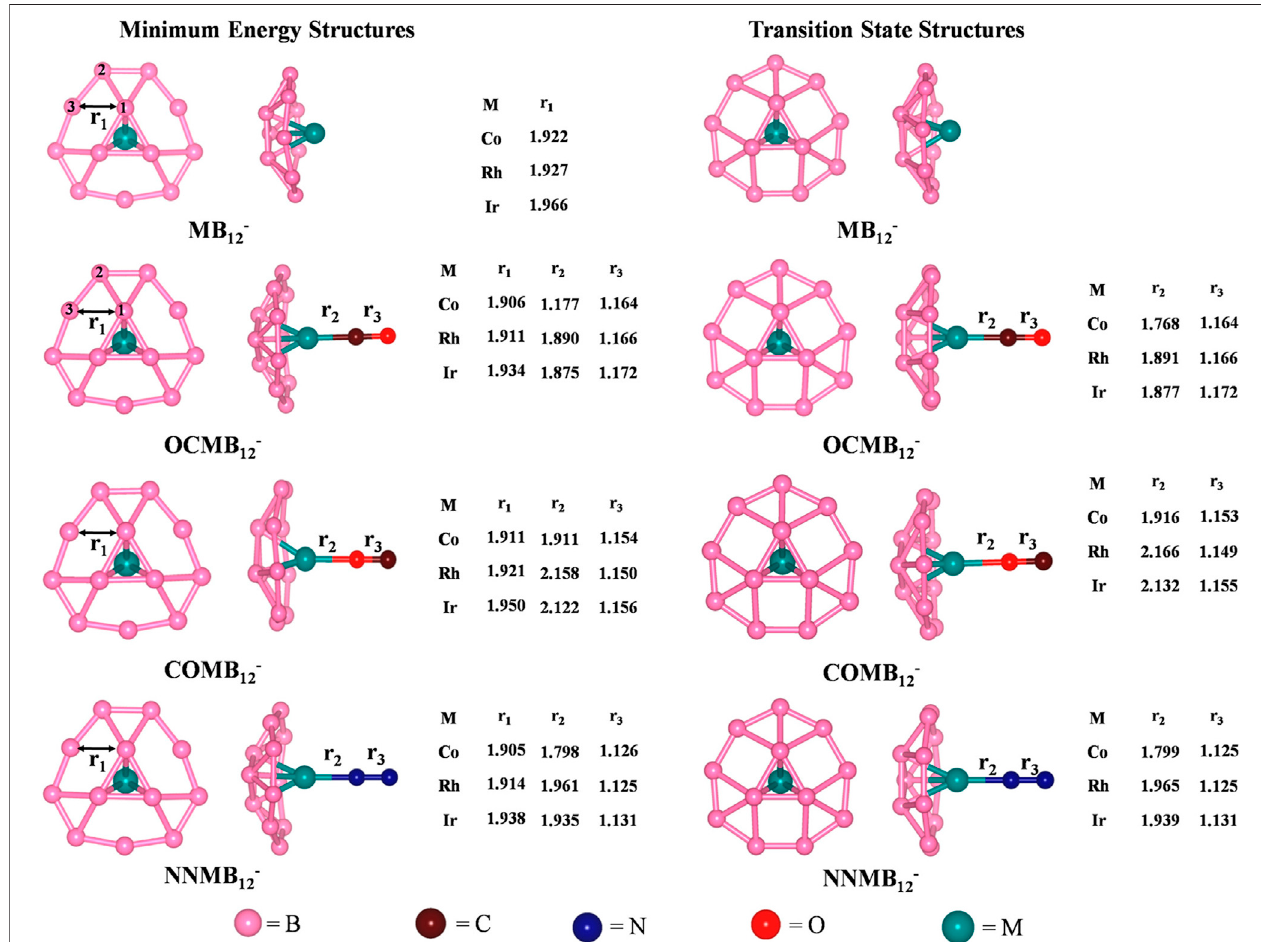
FIGURE10| Optimized geometriesofMB 12- andligandbound MB 12- at thePBE/def2-TZVPPD level,and theirtransitionstatestructuresfortheinternalrotationof the B 3 ring. Bond distances are provided in Angstrom unit. (Reprinted with permission from Saha et al., 2017. Copyright© 2017, American Chemical Society.).